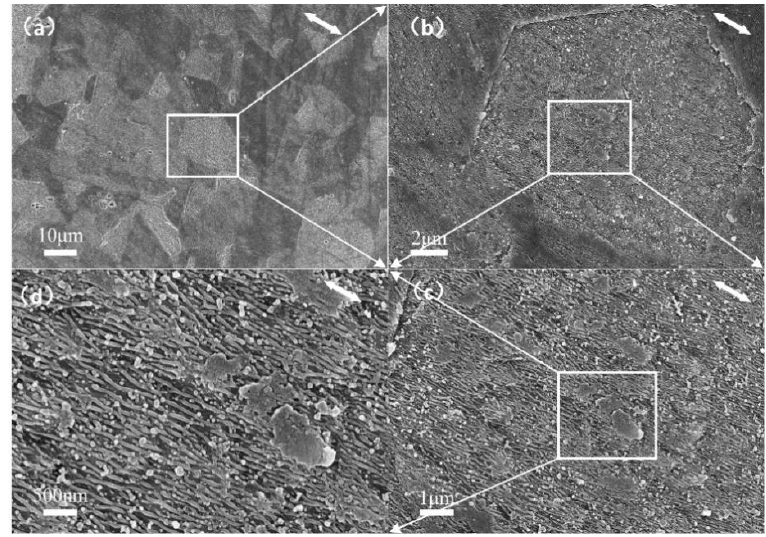
Figure 10. SEM images of the same sample of Figure 9b. ( a – d ) is the magnified picture of the selected area which indicated by a rectangular of white line.